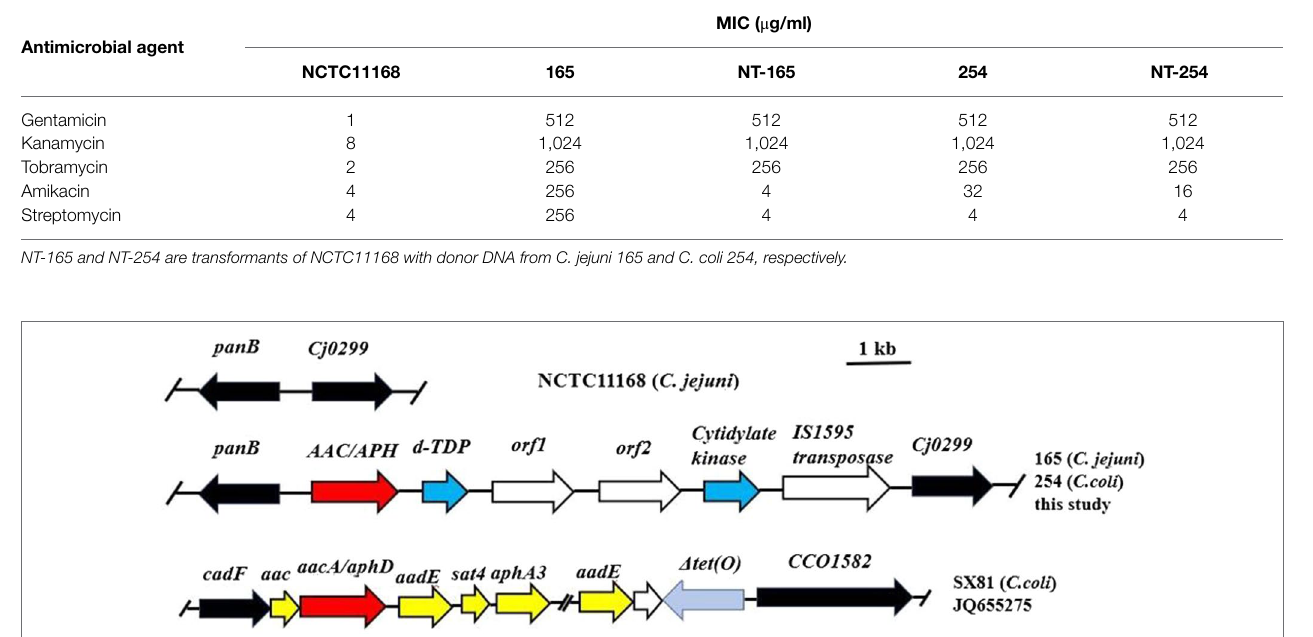
TABLE 3 | MICs of aminoglycosides in the transformants and donor strains.